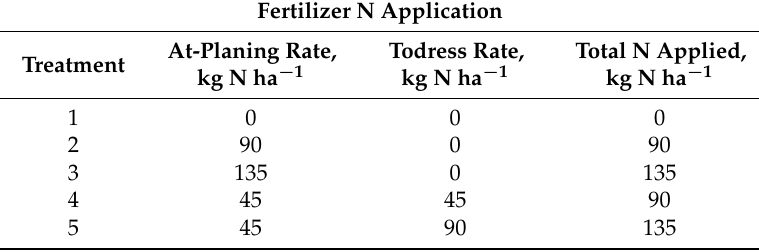
Table 3. Treatment, at-planting N rate, topdress N rate, and total N rate applied at six site-years in